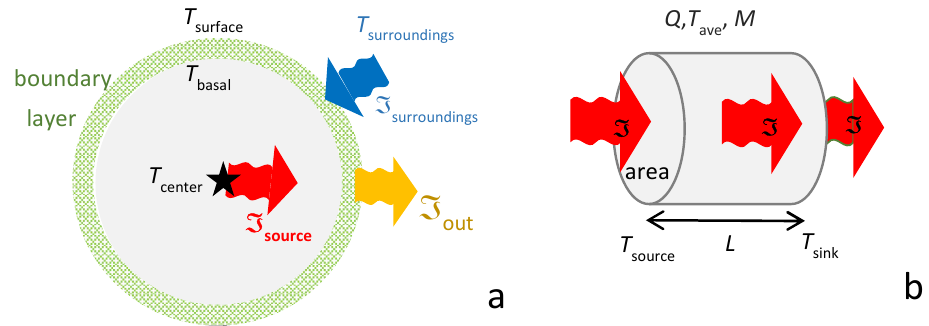
Figure 3. Schematics of conditions: ( a ) Spherical symmetry, which also applies to radial flow in a very long cylinder. Matter (grey circle) emits heat in accord with its temperature (orange squiggle arrow), but emissions are actually sampled from a surface boundary layer (stippled green shell). Constant flux is maintained either by a source (star) and/or externally (blue arrow); ( b ) Longitudinal flow in Cartesian (or cylindrical) symmetry. At steady state, flux along the special direction is a constant that is independent of position, so the axial thermal gradient is independent of time, and perpendicular slices are